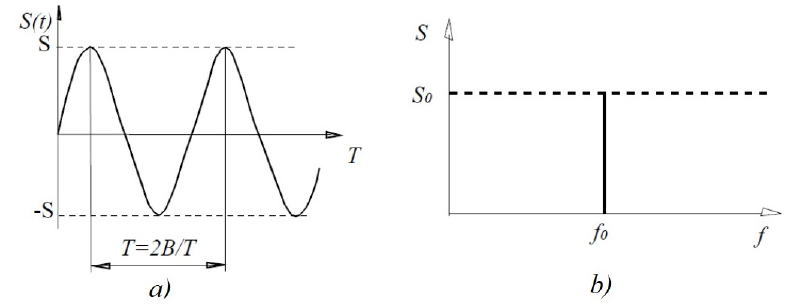
Figure 4. Harmonic vibration: ( a ) form; ( b ) frequency